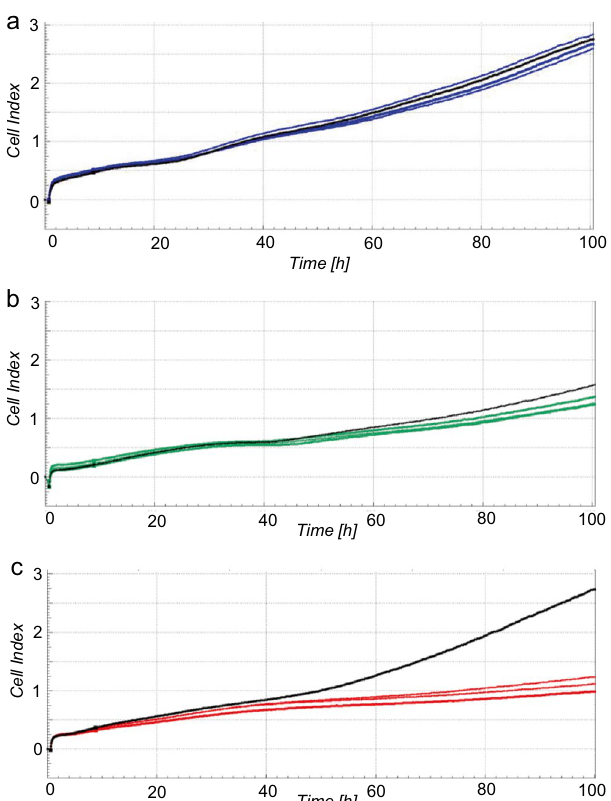
Figure 1. Impedance-based cell index after exposure of HGK to 72 h eluates of PP ( a ), BE ( b ), ME ( c ). The respective non-treated control is visualized in black. Each of the cell indices represents the average of a technical